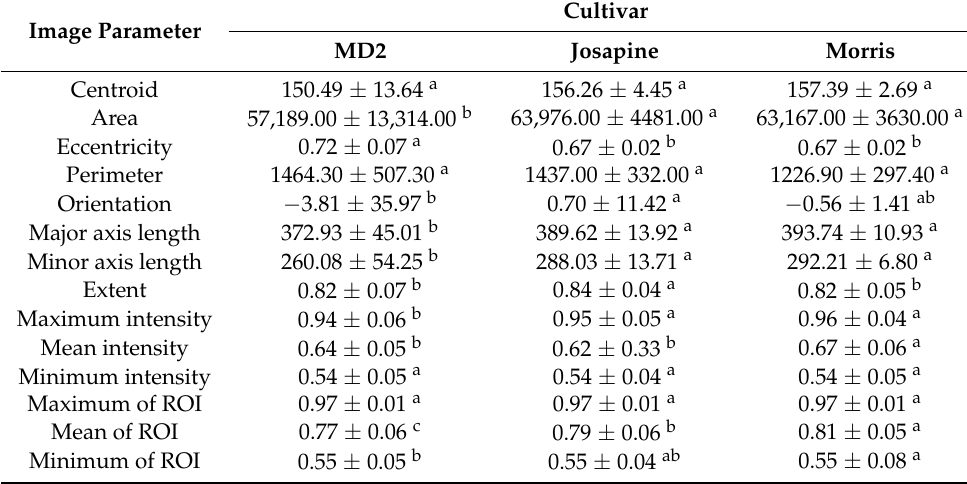
Table 1. Average values of image parameters from different pineapple